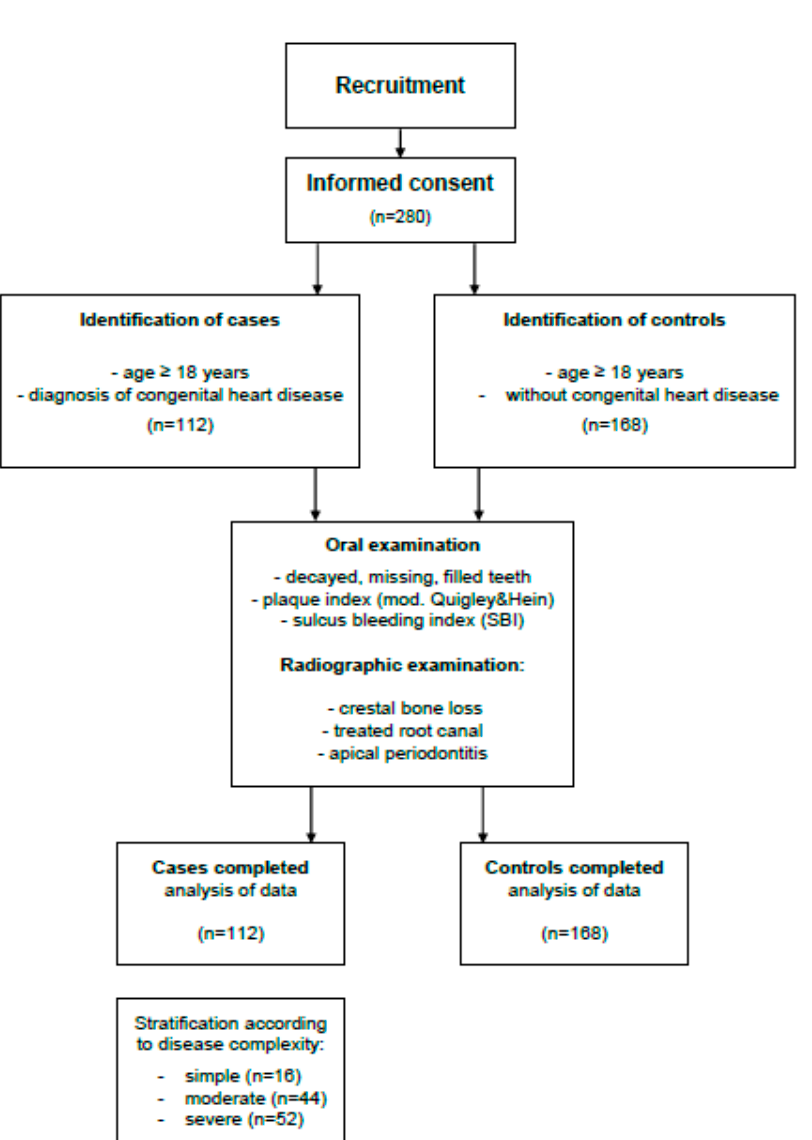
Figure 1. Flow diagram of recruitment process used for inclusion of cases and controls according to STROBE